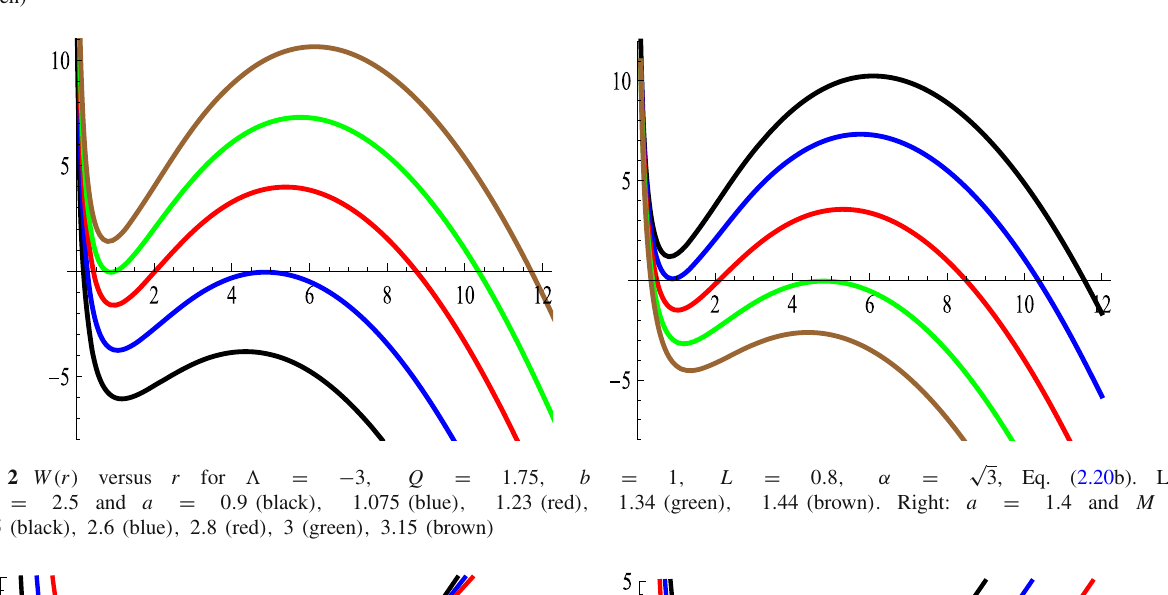
Fig. 2 W ( r ) versus r for (cid:11)